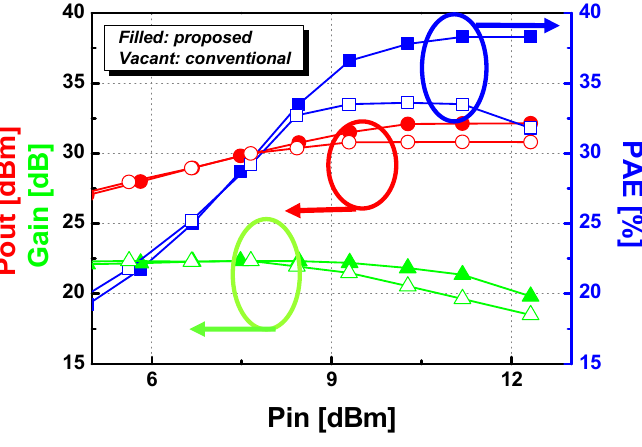
Figure 20. Measurement results. ( a ) Output power and PAE vs. frequency. ( b ) Harmonics vs. fre- quency.